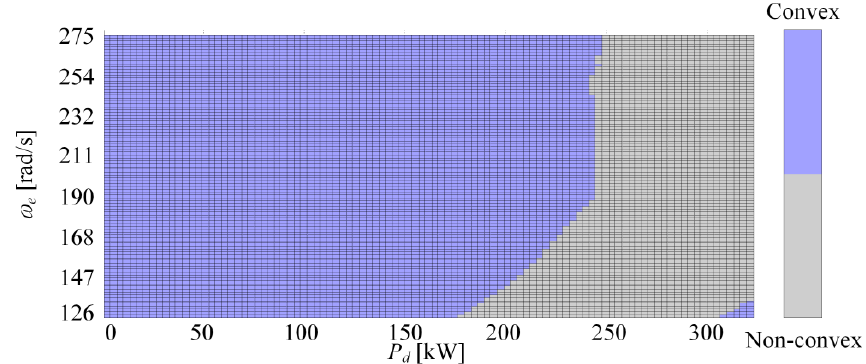
. m f vs. Figure 10. Character of 𝑚̇ Figure 10. Character of 𝑆𝑜𝐶̇ dependence (convex or non-convex) for a wide range of engine Figure 10. Character of 𝑚̇ 𝑓 vs. 𝑆𝑜𝐶̇ dependence (convex or non-convex) for a wide range of engine 𝑓 vs.